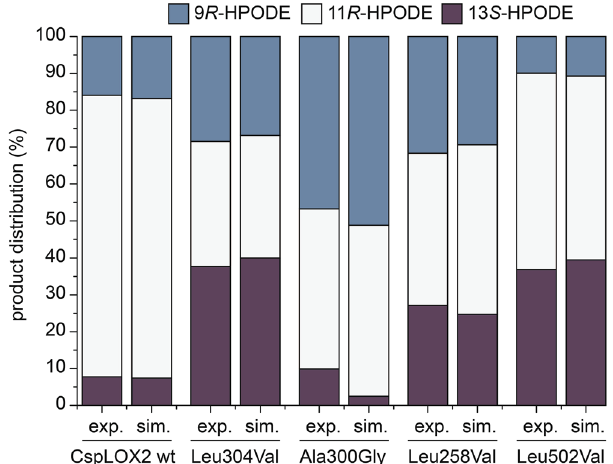
Figure 6. Product distributions for an antarafacial oxygen attack in CspLOX2 and its mutations. The distributions of the main stereo products of the CspLOX2 wt and a set of single amino acid mutations were calculated from MD simulations using a steric shielding model. The amount of C11 product was lowered by 10% and equally distributed to C9 and C13 in order to take the higher activation barrier of an oxygen attack at C11 into account. These results (sim.) are compared to the experimental distributions for these products (exp.) shown in Fig.